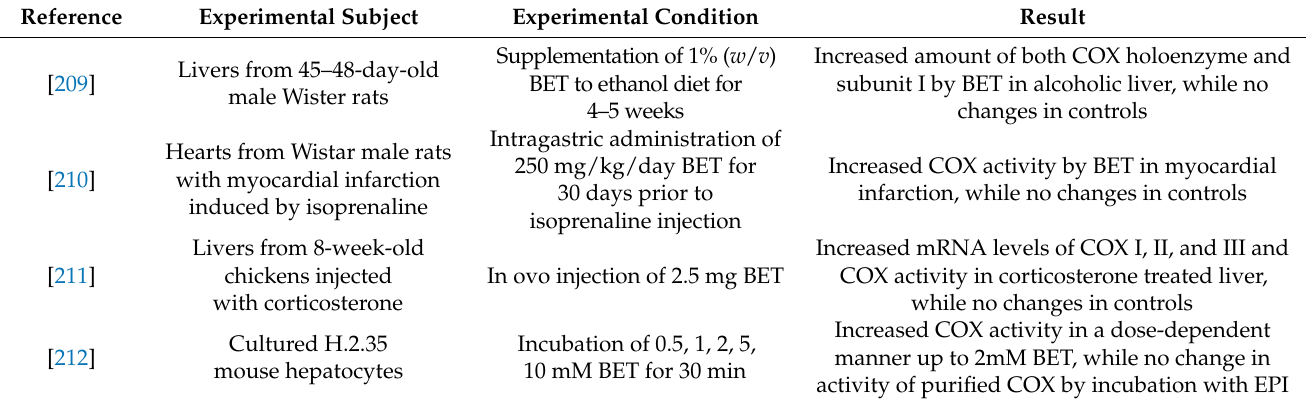
Table 3. Effect of betaine (BET) administration on cytochrome c oxidase